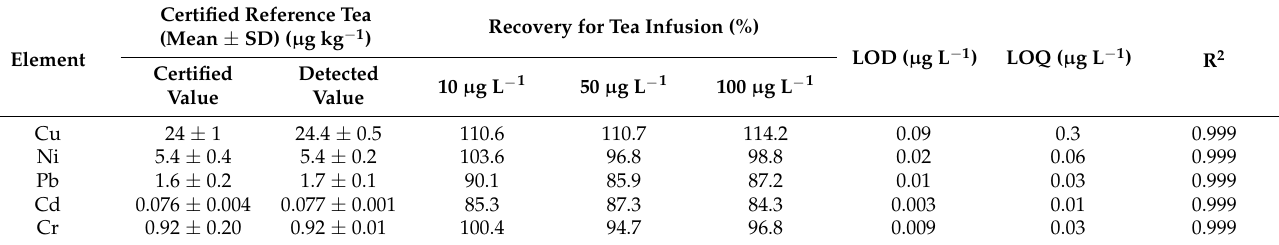
Table 3. LOD, LOQ, recovery, and the performance of the analytical